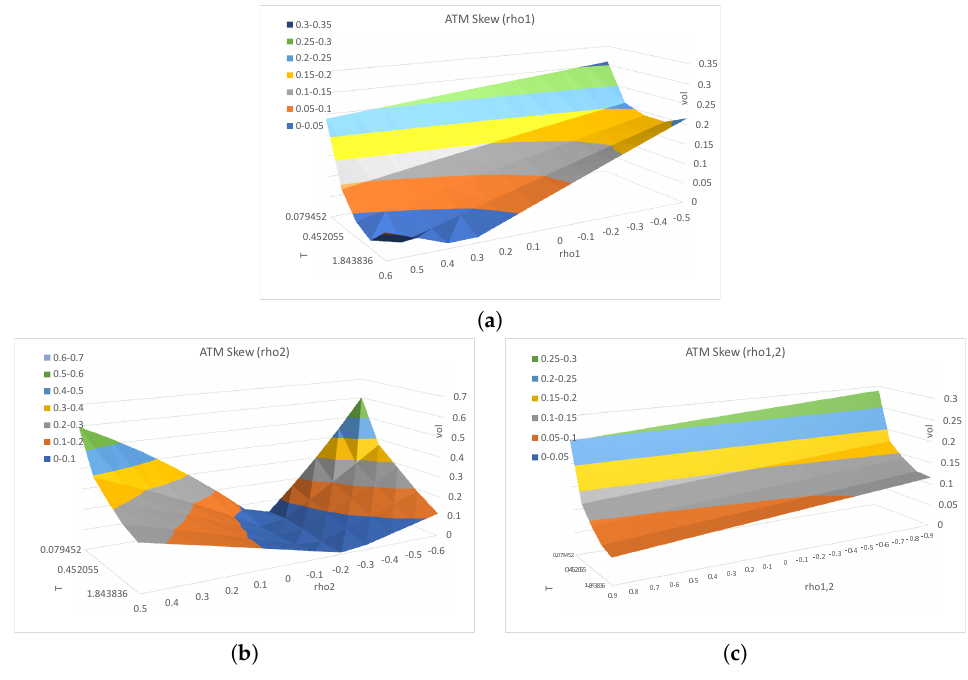
Figure 7. ATM skew with respect to the correlations. ( a – c ) show the ATM skew of ρ 1 , ρ 2 , and ρ 3 , respectively. The other parameters are listed in Table